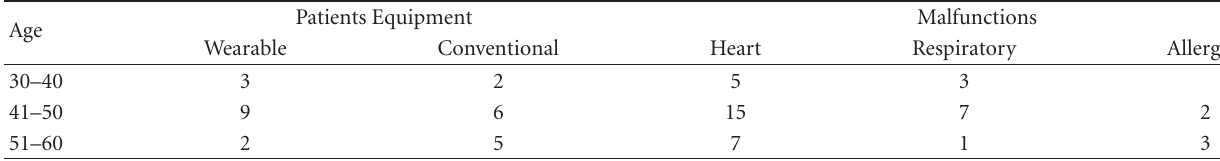
Table 5: Patient included in the